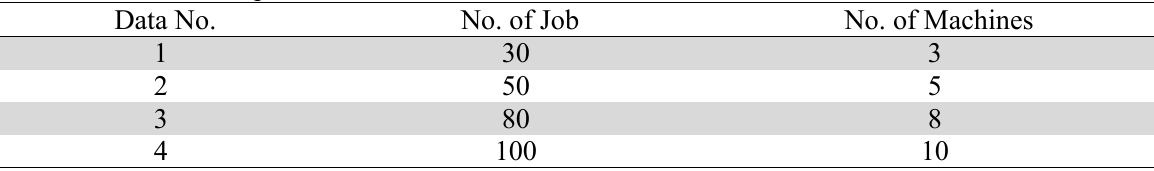
Dataset details of test